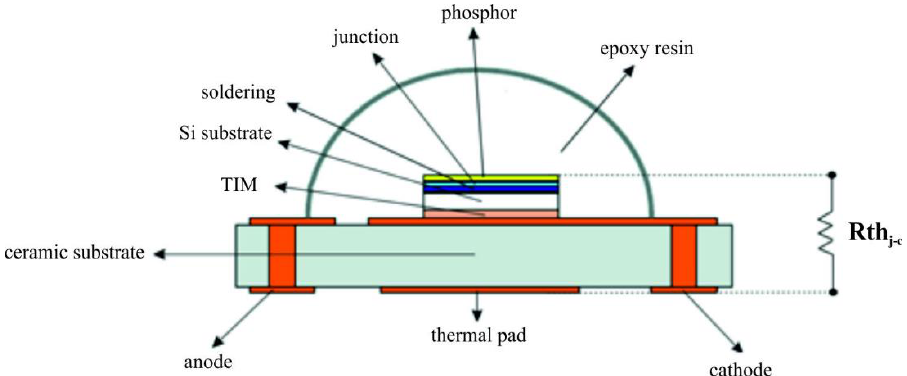
Figure 4. Typical construction of high power LED source.